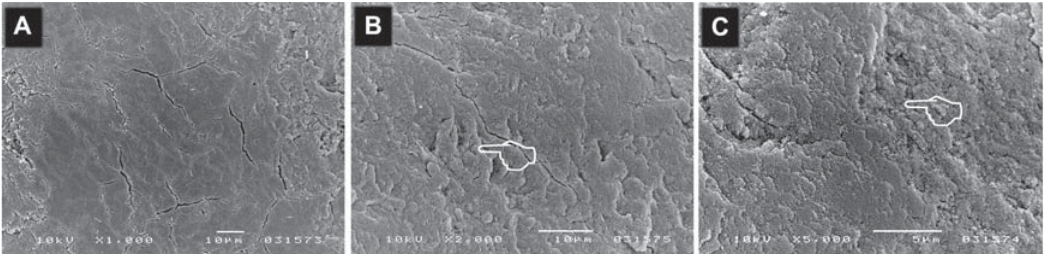
Figure 2- Scanning electron microscopy showing the morphology of the root surfaces treated with the piezoelectric scaler. A: non-surgical periodontal treatment performed with this method creates an irregular root surface with few shallow grooves; (cid:17)(cid:28)(cid:4)(cid:31)(cid:12)!(cid:31)(cid:8)(cid:9)(cid:4)"(cid:13)!(cid:24)(cid:12)(cid:10)(cid:11)(cid:13)(cid:30)(cid:12)(cid:2)(cid:24)(cid:4)(cid:18)(cid:19)(cid:20)(cid:21)(cid:22)(cid:22)(cid:22)(cid:23)(cid:4)(cid:5)(cid:31)(cid:2)(cid:15)(cid:12)(cid:24)!(cid:4)(cid:30)(cid:31)(cid:13)(cid:30)(cid:4)(cid:30)(cid:31)(cid:8)(cid:4)(cid:9)(cid:2)(cid:2)(cid:30)(cid:4)(cid:11)(cid:8)"(cid:8)(cid:24)(cid:30)(cid:6)"(cid:4)(cid:15)(cid:13)(cid:5)(cid:4)(cid:24)(cid:2)(cid:30)(cid:4)(cid:9)(cid:8)"(cid:2)%(cid:8)(cid:25)(cid:4)#$(cid:4)(cid:30)(cid:31)(cid:8)(cid:4)(cid:6)(cid:14)(cid:30)(cid:9)(cid:13)(cid:5)(cid:2)(cid:24)(cid:12)(cid:11)(cid:4)(cid:12)(cid:24)(cid:5)(cid:30)(cid:9)(cid:6)"(cid:8)(cid:24)(cid:30)(cid:13)(cid:30)(cid:12)(cid:2)(cid:24)(cid:4)#(cid:6)(cid:30)(cid:4) (cid:15)(cid:13)(cid:5)(cid:4)(cid:2)(cid:24)(cid:14)$(cid:4)(cid:13)(cid:14)(cid:30)(cid:8)(cid:9)(cid:8)(cid:25)(cid:4)(cid:13)(cid:24)(cid:25)(cid:4)(cid:11)(cid:31)(cid:13)(cid:9)(cid:13)(cid:11)(cid:30)(cid:8)(cid:9)(cid:12)=(cid:8)(cid:25)(cid:4)#$(cid:4)(cid:7)(cid:12)(cid:30)(cid:5)(cid:4)(cid:13)(cid:24)(cid:25)(cid:4)(cid:30)(cid:12)(cid:7)(cid:5)(cid:4)(cid:18)(cid:7)(cid:2)(cid:12)(cid:24)(cid:30)(cid:8)(cid:9)(cid:23)(cid:16)(cid:4)(cid:26)(cid:28)(cid:4)(cid:18)(cid:19)(cid:27)(cid:21)(cid:22)(cid:22)(cid:22)(cid:23)(cid:4)(cid:7)(cid:9)(cid:8)(cid:5)(cid:8)(cid:24)(cid:11)(cid:8)(cid:4)(cid:2)(cid:3)(cid:4)(cid:13)(cid:4)(cid:7)(cid:2)(cid:9)(cid:2)(cid:6)(cid:5)(cid:4)(cid:13)(cid:24)(cid:25)(cid:4)(cid:30)(cid:31)(cid:12)(cid:24)(cid:4)(cid:14)(cid:13)$(cid:8)(cid:9)(cid:4)(cid:2)(cid:3)(cid:4)(cid:25)(cid:8)#(cid:9)(cid:12)(cid:5)(cid:4)(cid:15)(cid:12)(cid:30)(cid:31)(cid:4)